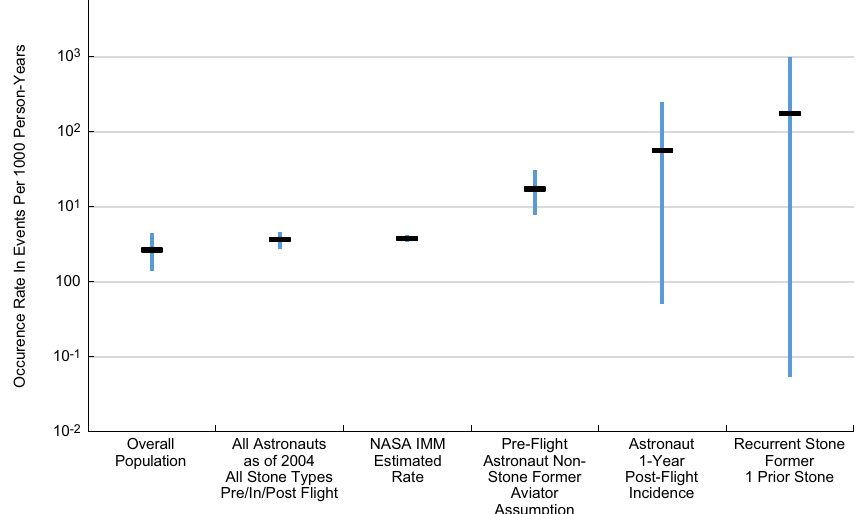
Fig. 1 Comparison of estimated symptomatic calcium kidney stone occurrence rates for astronaut risk. Comparing occurrence rates, including fi rst presentation incidence rates, evaluated for the overall population 13 , all pre- fl ight, in- fl ight, post- fl ight 9 astronauts, the NASA IMM Risk Model 1 , analogous pre- fl ight astronaut non-stone former aviator assumption 52 , and 1-year post- fl ight astronauts to recurrent stone formers 16 illustrates the degree of ambiguity possible in predicting astronaut symptomatic calcium kidney stone formation rates. The calculations for the 1-year post- fl ight astronaut rate are described in the “ Methods ” and tabulated in Table 4 with all population incidence and recurrence rates identi fi ed for this study. The overall population rate is below the astronauts ’ rate. This is to be expected, considering the astronaut population has a higher proportion of males than the general population 91 , and males have a higher incidence rate of renal stones 13 . Additionally, the various astronaut incidence rate estimates either include post- fl ight astronauts or are premised on analogous aviator population data that have a higher incidence of renal stones 52 , as shown in the “ Methods ”